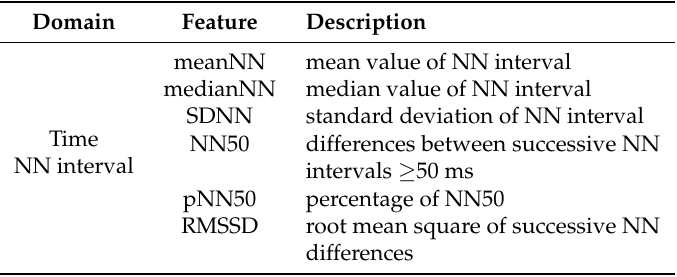
Table 1. Description of the time domain